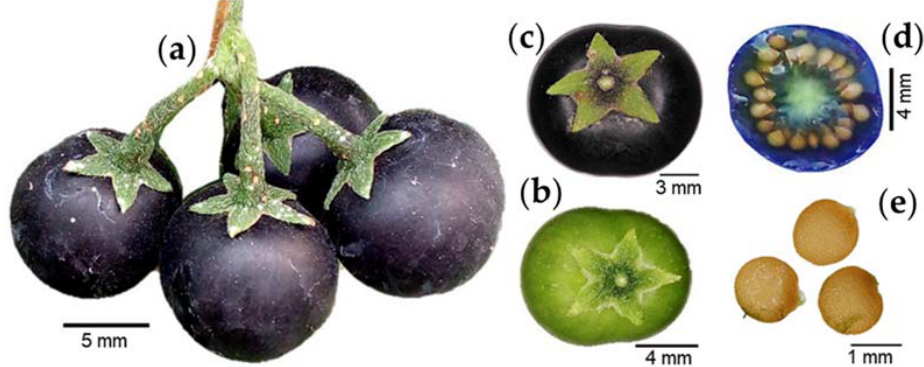
Figure 3. Fruit clusters ( a ), immature ( b ) and ripe fruit ( c ), pulp ( d ), and seeds ( e ) of slender nightshade plant ( Solanum nigrescens ). Photos by Sara Monzerrat Ramírez-Olvera ( a , d ) and Jorge Manuel Valdez-Carrasco ( b , c , e ).